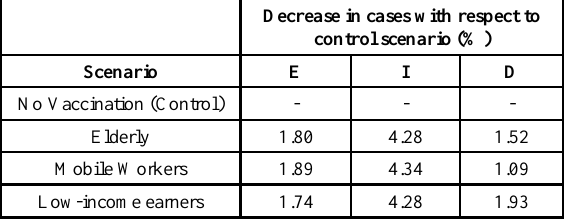
Table 3. Simulation Results